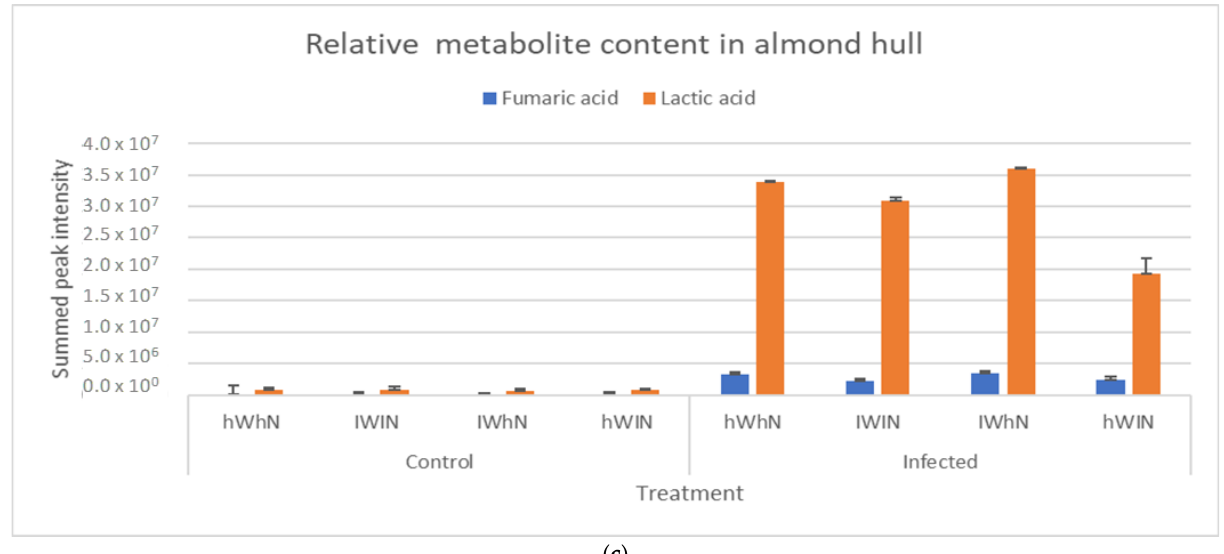
Figure 10. Relative sugar and metabolite content in the control and infected (isolate 19A – 0030) hull samples with standard deviation. ( a ) Glucose, fructose, sucrose, and xylose ( b ) asparagine, ( c ) fumaric acid and lactic acid. Data presented are the relative concentration of sugars, fumaric acid, and lactic acid (as determined from NMR) with standard deviation (error bars), n = 30. Nitrogen and